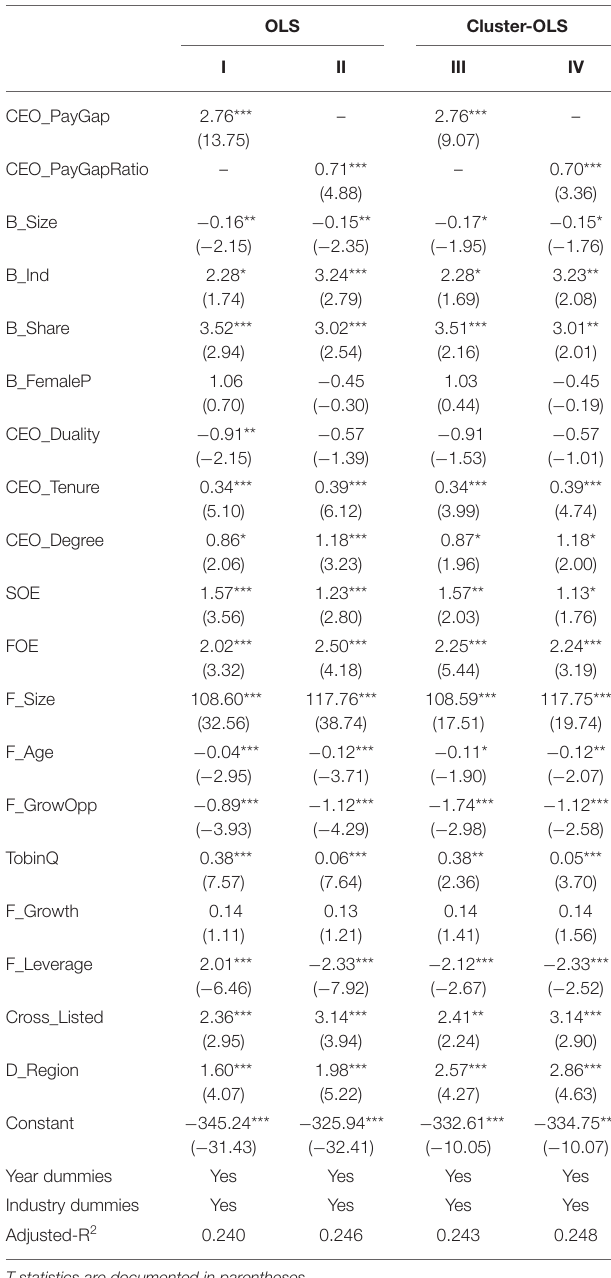
TABLE 1 | Effect of CEO tournament incentive on corporate social responsibility